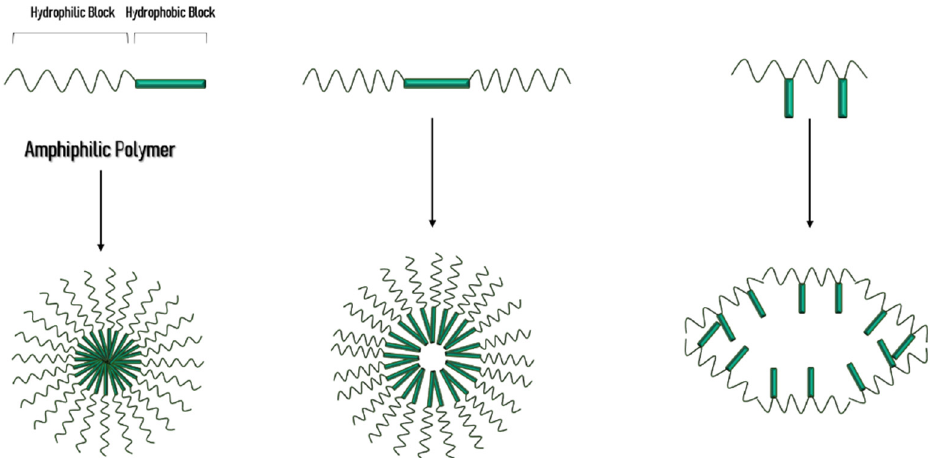
Figure 1. Schematic representation of the polymeric micelles formed by different polymers.